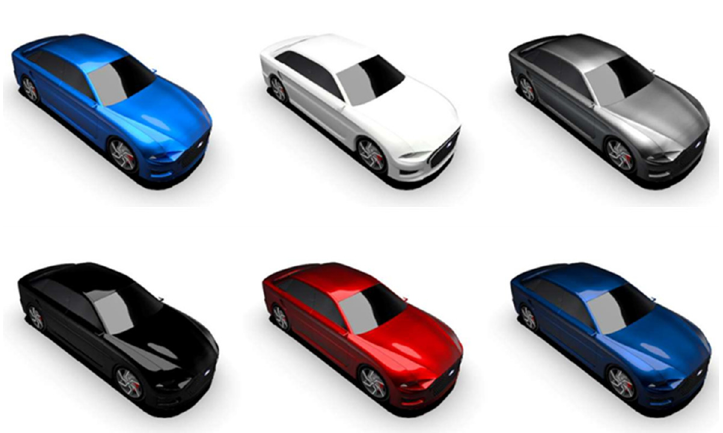
Figure 10. Different color representations of the car model.